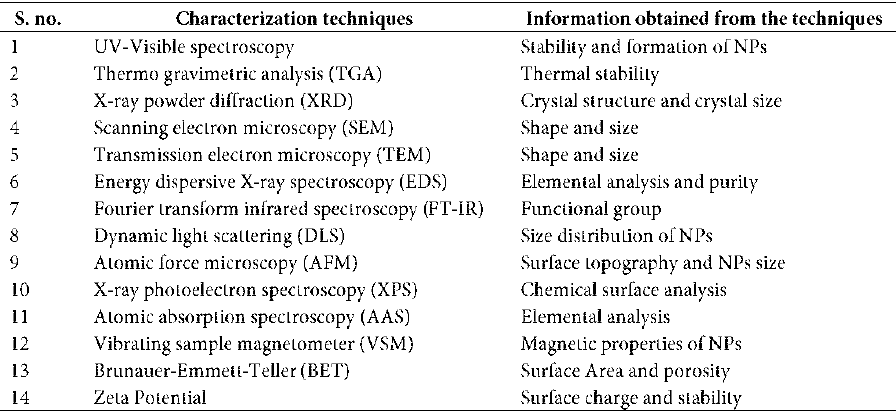
Table 2. Characterization techniques for